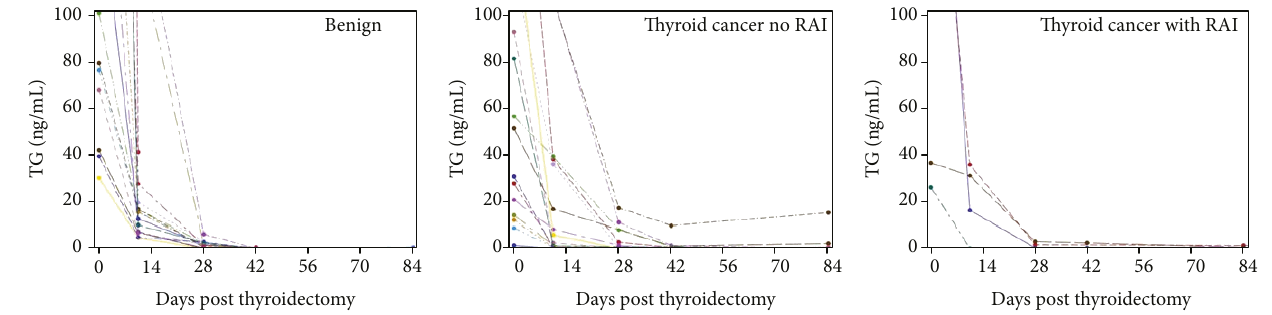
Figure 5: TG level trend in each subject following total